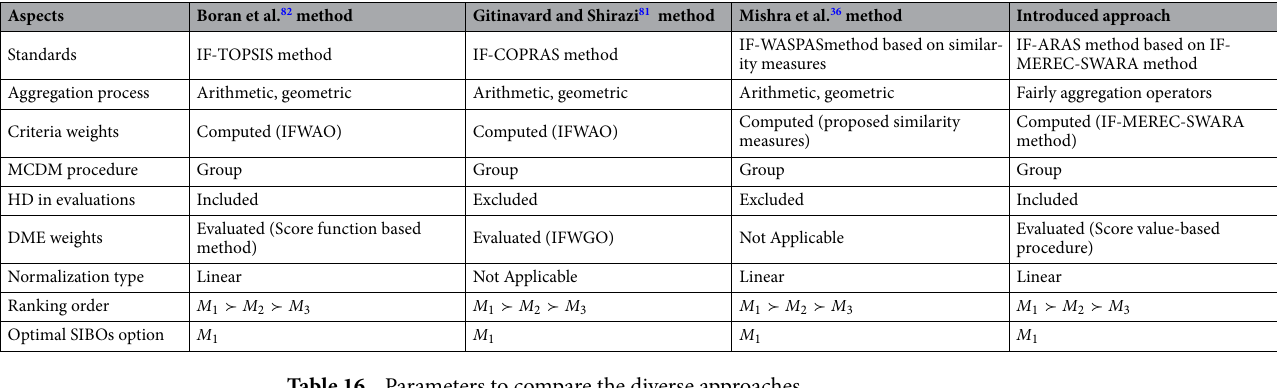
Table 16. Parameters to compare the diverse approaches.